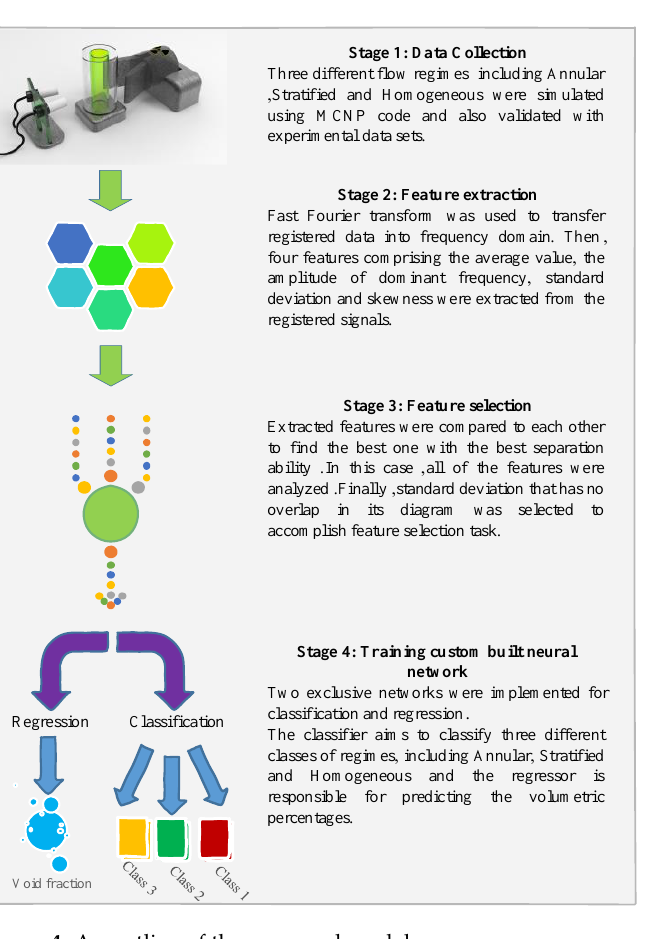
Figure 4. An outline of the proposed model. Registered photon energy spectra for the 3 flow regimes (void fraction = 5%) are shown in Figure 5.